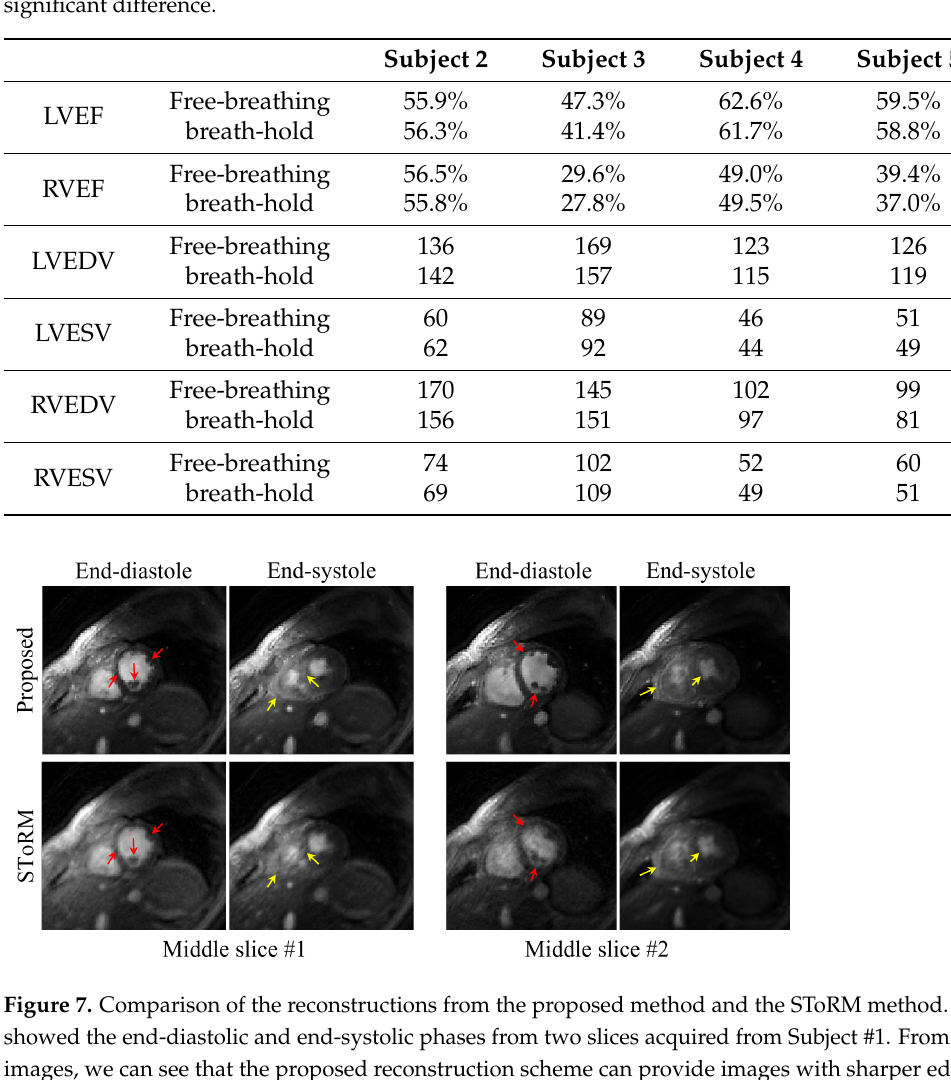
Table 2. LVEF and RVEF comparison. Since bulk motions were introduced during the data acquisition of subject #1 and we do not have the matching breath-hold and free-breathing slices for this subject. Therefore, the LVEF and RVEF are compared based on only four subjects. The LVEF calculated from the free-breathing and ungated images and the LVEF calculated from the fully-sampled breath-hold images have a p -value of 0.295. The RVEF calculated from the free-breathing and ungated images and the RVEF calculated from the fully-sampled breath-hold images have a p -value of 0.184. The p -values indicate that the LVEF and RVEF got from the free-breathing images and breath-hold images have no significant difference.